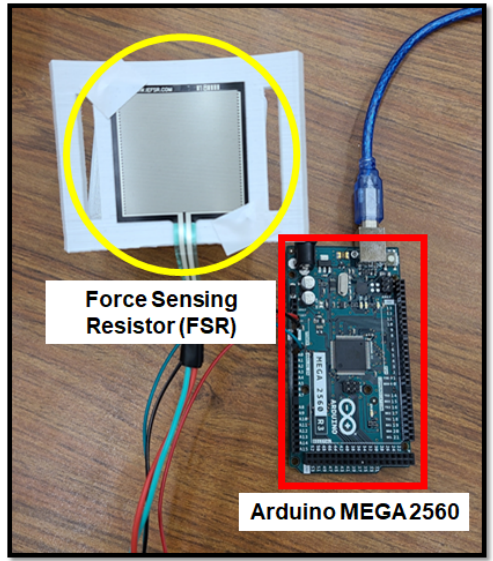
Figure 5. FSR sensor and Arduino setup.